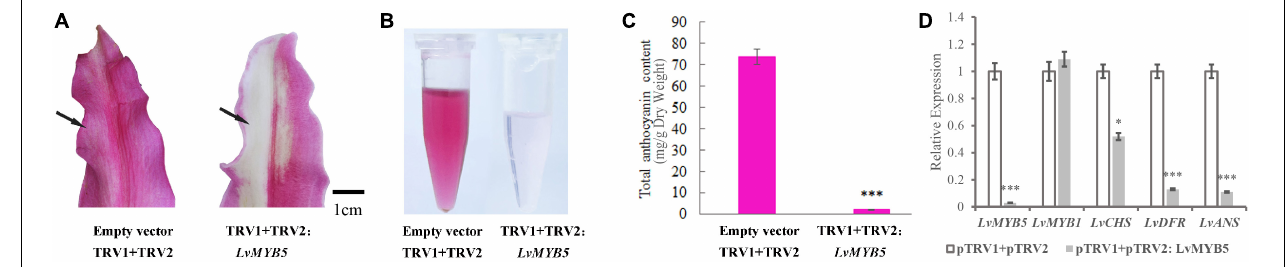
FIGURE 6 | Verification of the function of LvMYB5 by virus-induced gene silencing (VIGS). (A) Lily petals after treatment. (B) Extraction of total anthocyanins from lily petals after treatment. (C) Determination of total anthocyanin contents in lily petals ( ∗ p ≤ 0.1, ∗∗∗ p ≤ 0.01). (D) Expression levels of structural genes and MYB gene in lily petals.